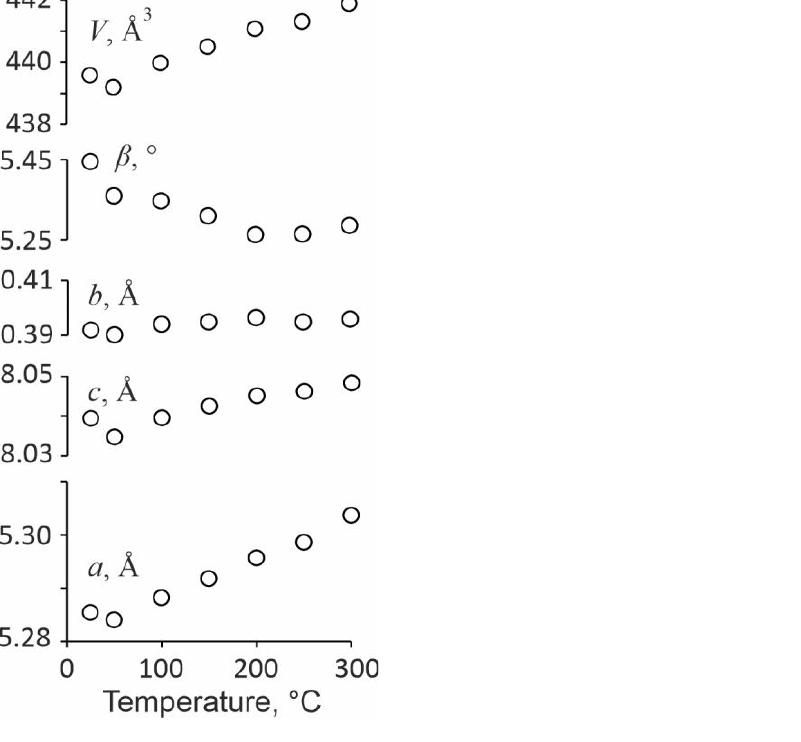
Figure 5. The temperature-induced evolution of the unit-cell parameters ( a , b , c , β and V ) of BaAs 2 Zn 2 O 8 · H 2 O. The errors are smaller than the size of the symbols. Thermal expansion coefficients (TECs) calculated with the linear approximation of the unit-cell parameters’ temperature dependencies are the following: α 11 = 16.0(8), α µ ( α α a = 13.2(9), α α α c = 5.3(9), α β = 33 = 3.5(9), 33 ˆ c ) = 22.6(6), 22 = 1.7(5), b =